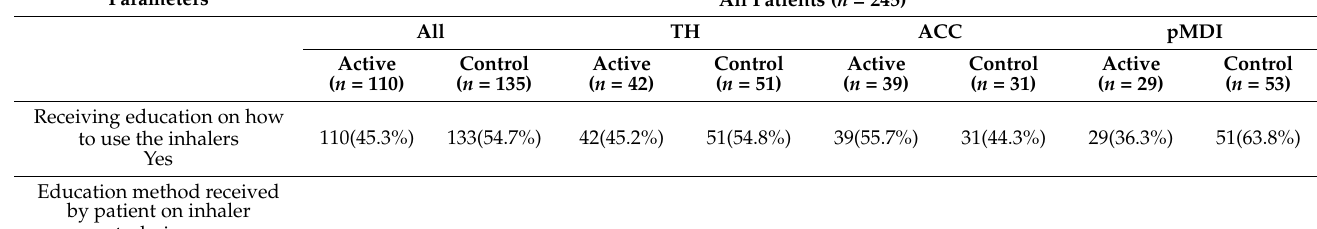
Table 2. Advice and education received on asthma inhaler device use as reported by patients in the three study groups. Parameters